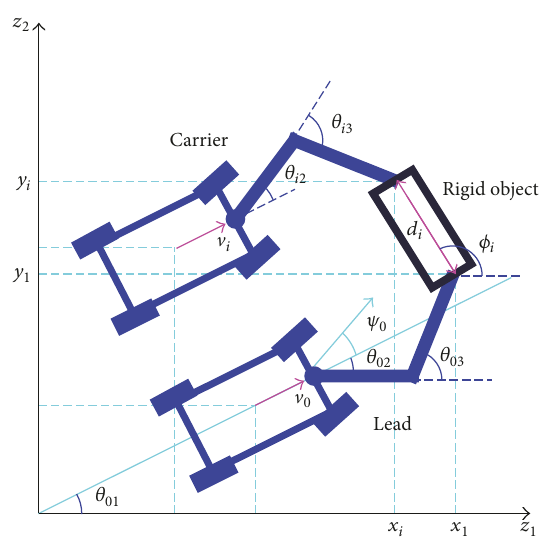
Figure 3: Schematic representation of the lead-carrier in the 𝑧 1 - 𝑧 2